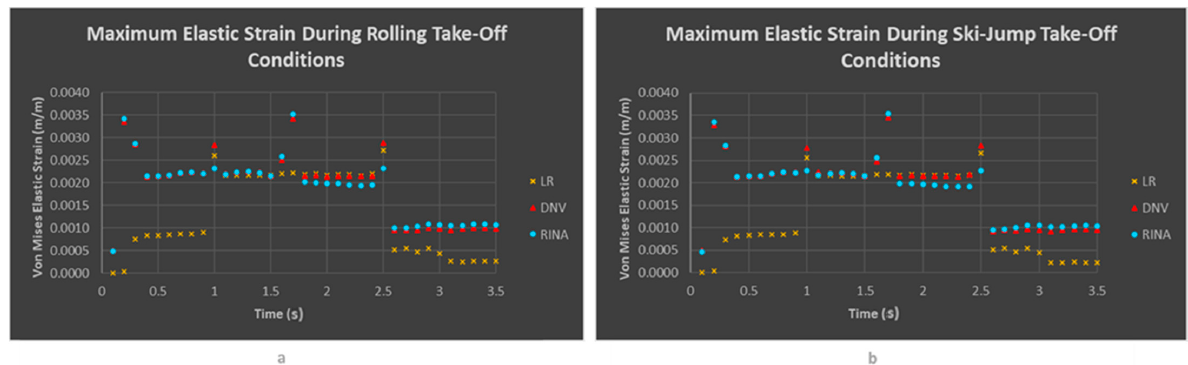
Figure 15. Maximum elastic strain of the deck plate under the take-off condition; ( a ) dynamic take-off and ( b ) ski-jump.